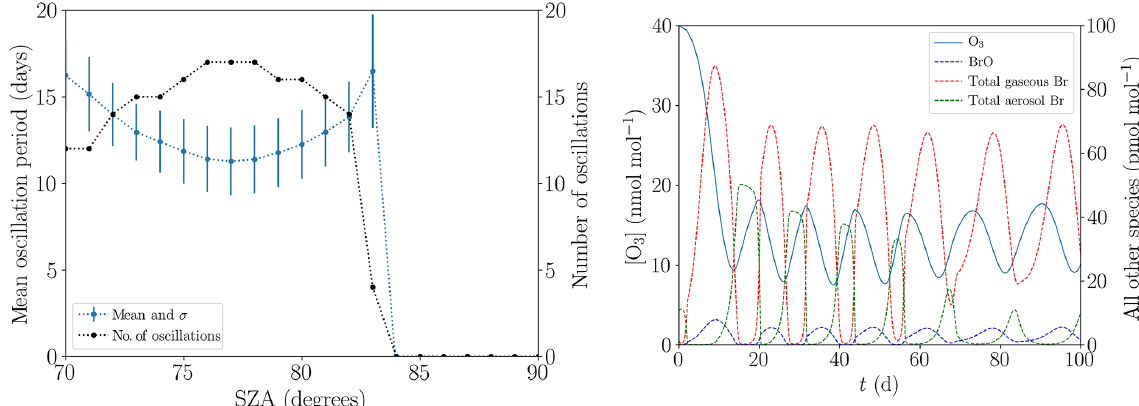
Figure 13. (a) Mean oscillation period and number of oscillations versus the solar zenith angle during 200d. (b) Evolution of the mixing ratios of O 3 and the bromine species for SZA = 70 ◦